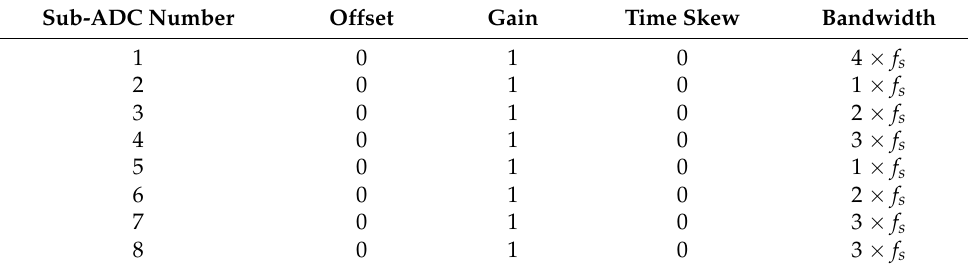
Table 1. The mismatches of the TI-ADCs simulation system.